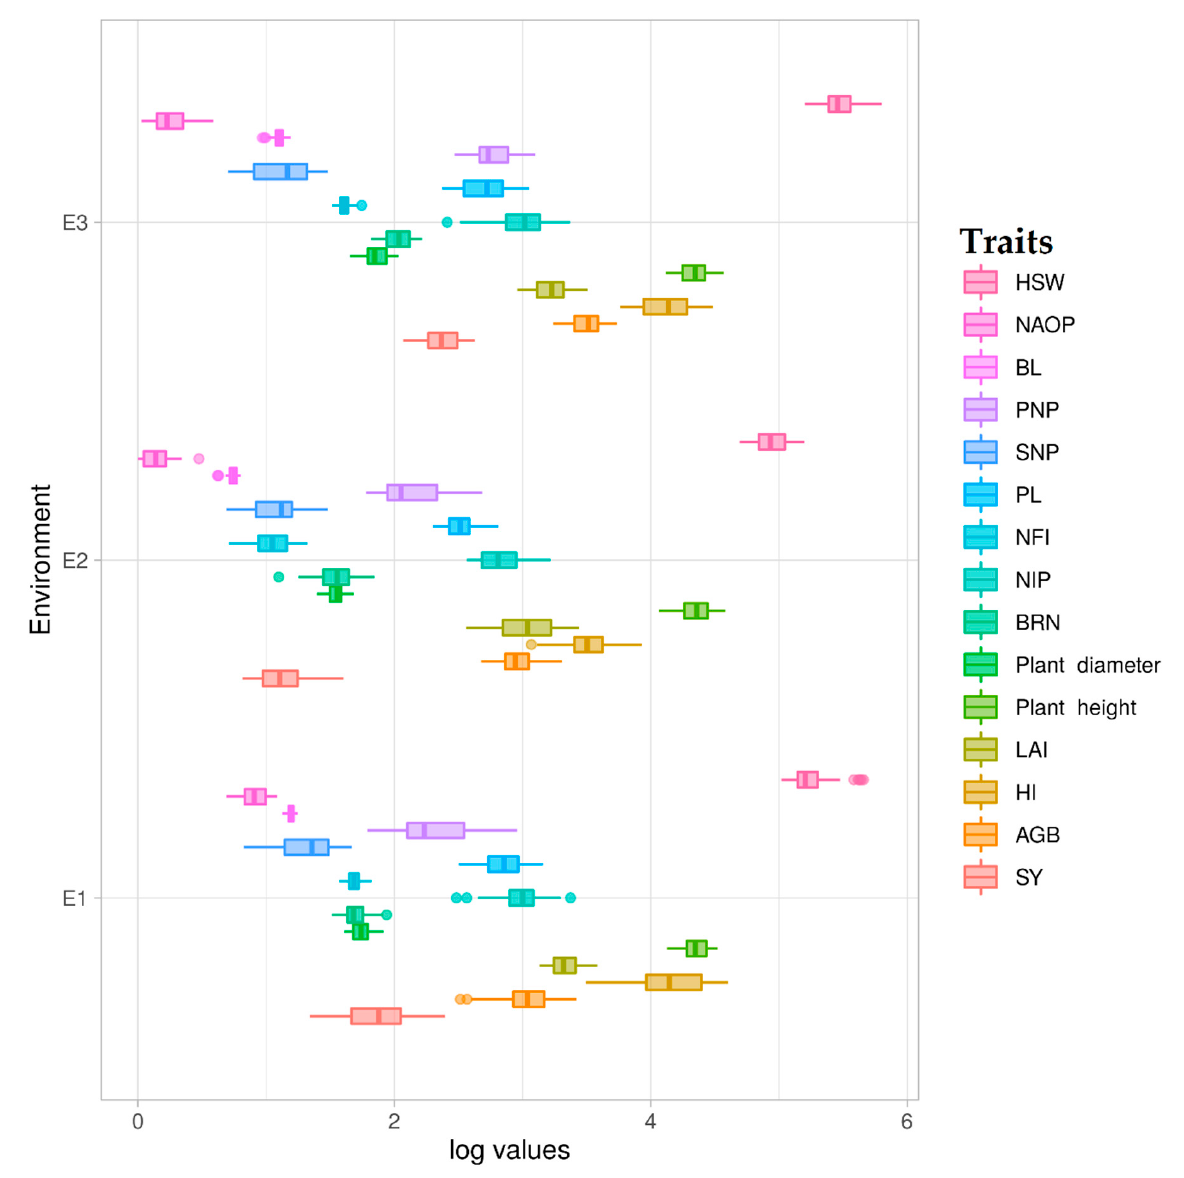
Figure 3. Box plot of variation of faba bean yield and morphologic parameters of 15 landraces across three consecutive growing seasons. HSW = hundred seed weight; NAOP = number of aborted ovules/pods; BL = banner length; PNP = pods number per plant; SNP = number of seeds per pod; PL = pod length; NFI = number of flowers per inflorescence; NIP = number of inflorescences per plant; BRN = branch number; LAI = leaf area index; HI = harvest index; AGB = above ground biomass and SY = seed yield. E1, E2m, and E3 were the 2018/2019, 2019/2020, and 2020/2021 growing seasons, respectively.